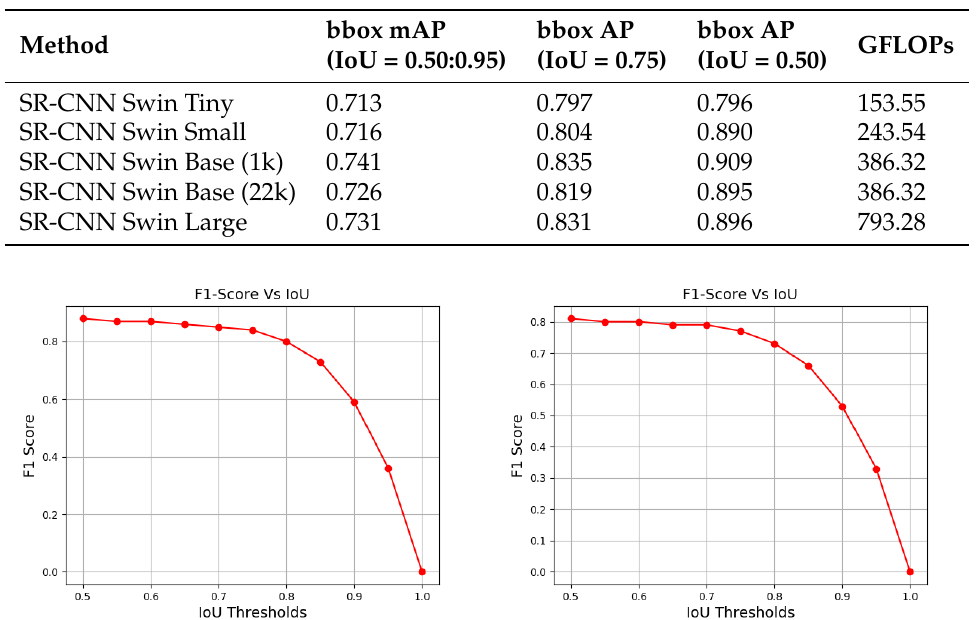
Figure 10. The F1-Score vs. IoU thresholds for the SR-CNN model. The first image shows results for the validation set and the second image for the test set of the IIIT-AR-13K [9]